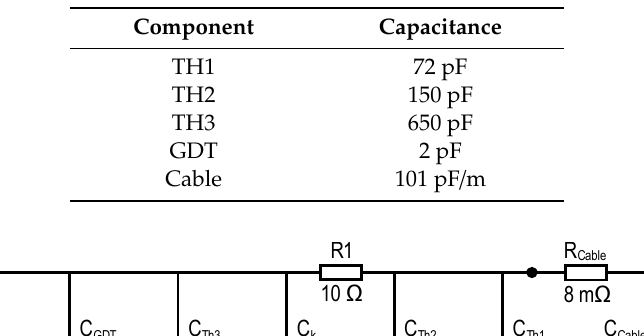
Table 2. Equivalent capacitance of PCB components.